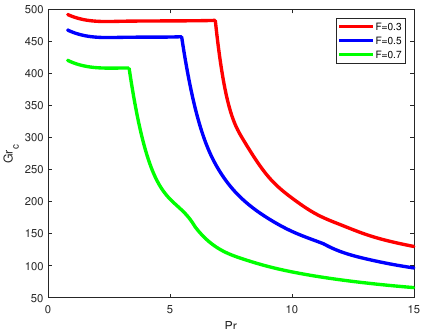
Figure 14. Critical Grashof numbers versus Pr for Case 1.